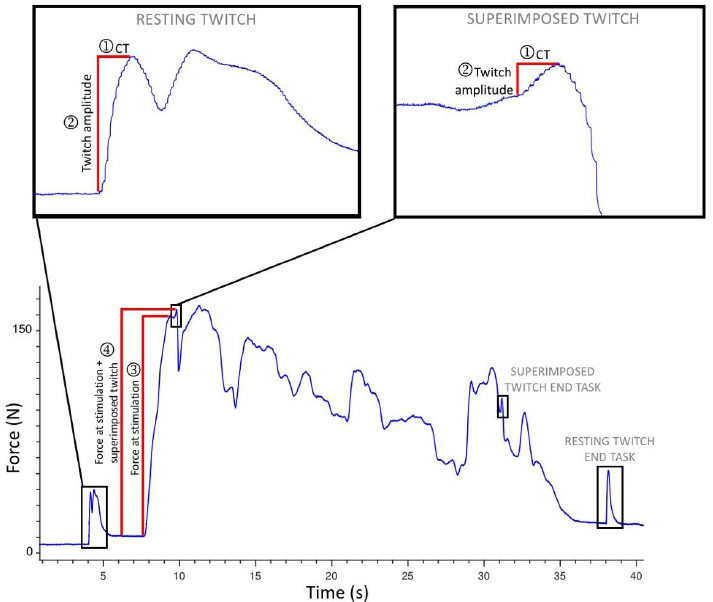
Figure 2. Force trace showing 30-s isometric maximal voluntary contraction (MVC) task for an individual participant, with resting and superimposed twitches identified at the start and end of the task for the calculations of voluntary activation (VA) and central fatigue. CT = contraction time.